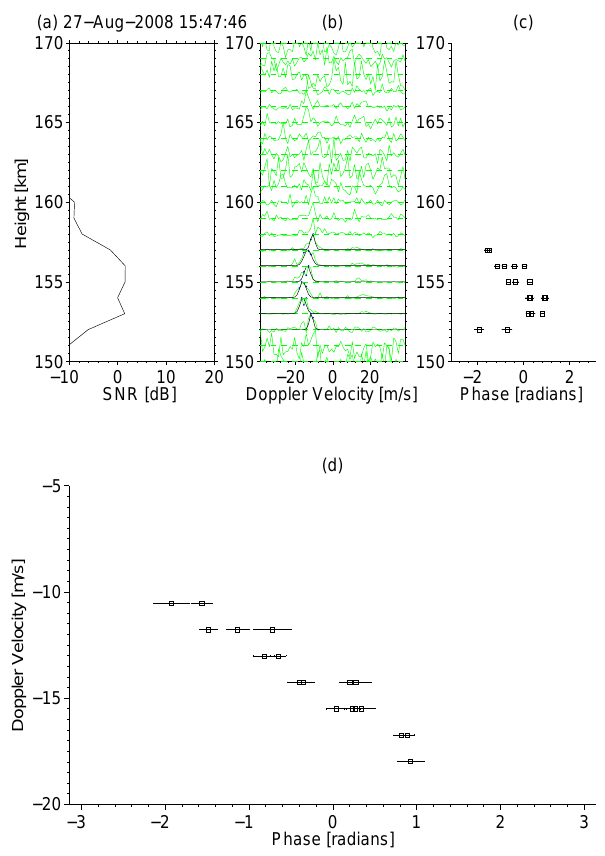
Fig. 8. Example of 150-km echoes observed over S˜ao Lu´ıs on 27 August 2008 at 12:47LT. (a) SNR profile. (b) Measured (green solid lines) and fitted (black solid lines) spectra as a function of height. (c) Differential phase estimated from spaced antenna ob- servations (see text). (d) Estimated phases versus corresponding Doppler